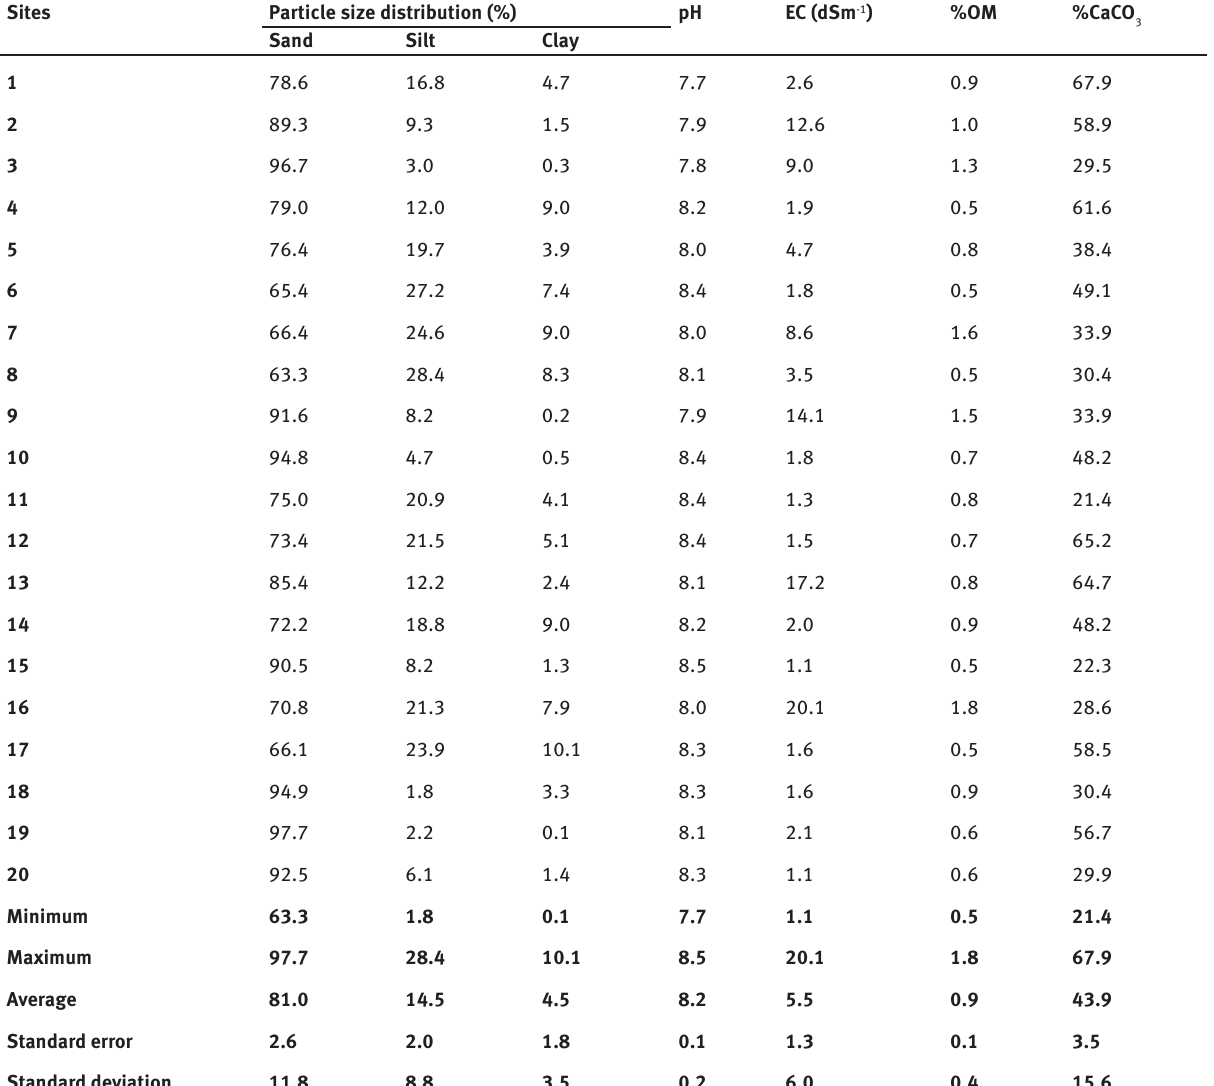
Table 2: Descriptive statistics of different physico-chemical characteristics of soil samples studied around the cement factory.